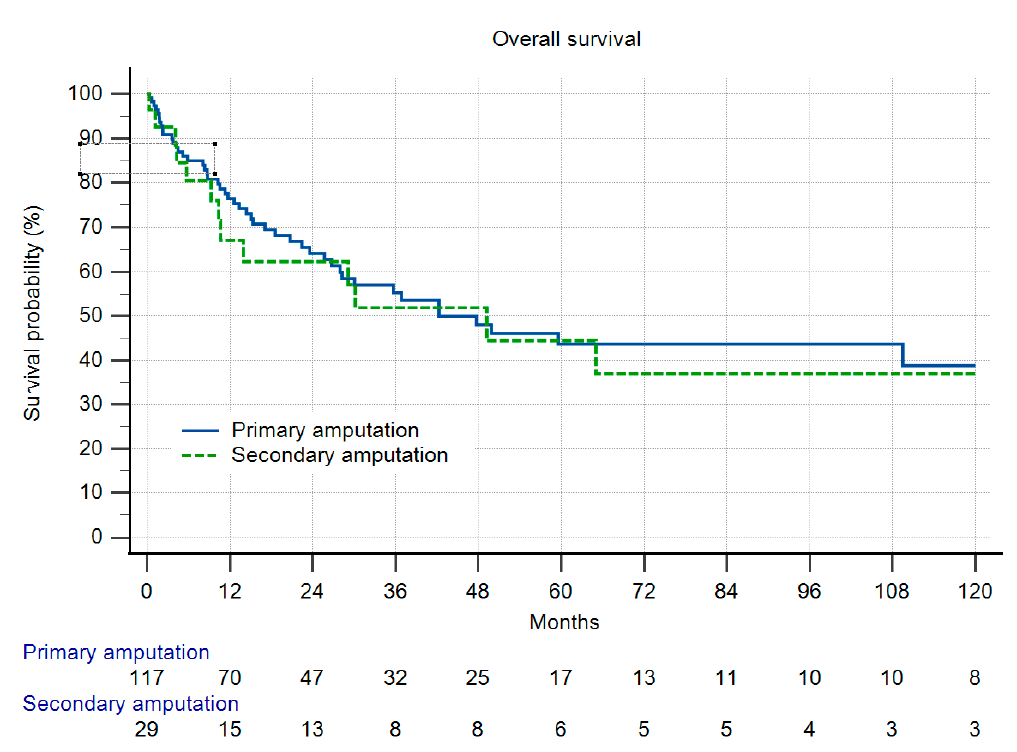
Figure 4. Overall survival (OS) in 146 patients with primary or secondary amputations (three patients excluded due to insufficient data), n.s.